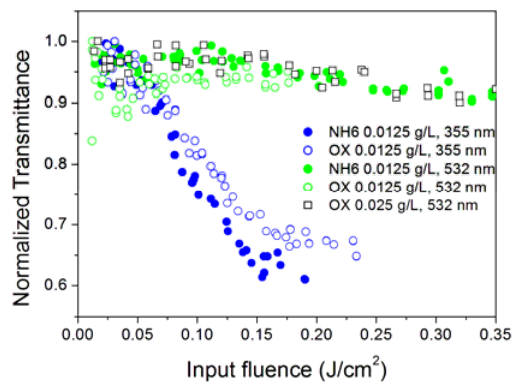
Figure 11. Optical limiting behavior of the NH6 and OX samples. It can be seen that the OX sample did not show optical limiting (OL) at 532 nm at the concentration of 0.0125 g / L (green hollow circles, no decrease in the transmittance with respect to the linear value).